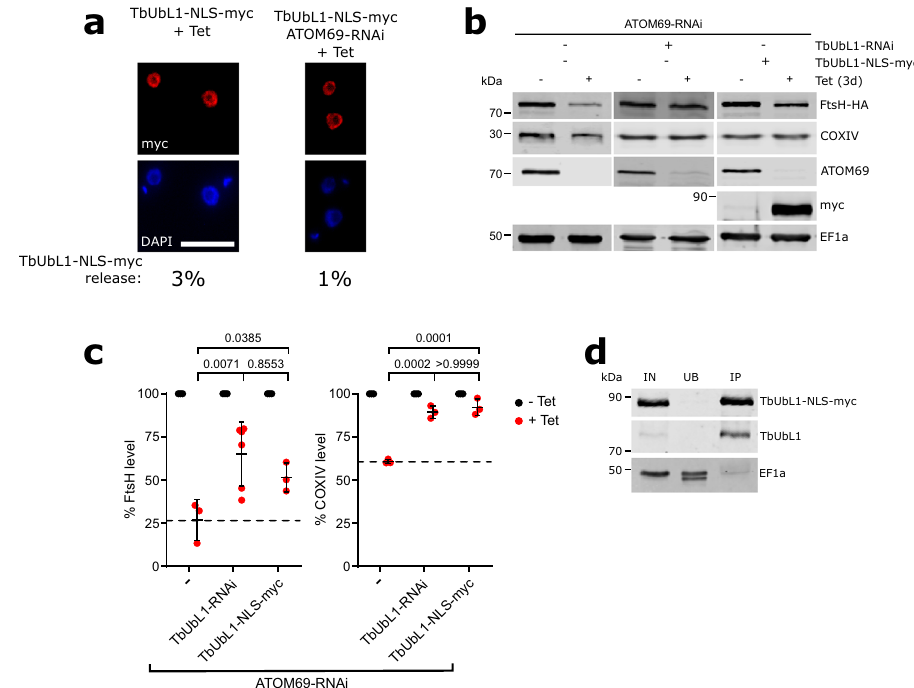
Fig. 7 Nuclear export of TbUbL1 is essential for proteasomal digestion of FtsH. a Left, immuno fl uorescence (IF) analysis of a cell line allowing tetracycline-inducible expression of ubiquitin-like protein 1 (TbUbL1) containing a nuclear localisation signal (NLS) in front of the C-terminal myc-tag (TbUbL1-NLS-myc + Tet). Right panels, IF analysis of a cell line allowing tetracycline-inducible expression of TbUbL1 containing a NLS in front of the C-terminal myc-tag together with simultaneous RNAi of atypical translocase of the outer membrane 69 (ATOM69) (TbUbL1-NLS-myc/ATOM69-RNAi + Tet). Cells were induced for 3d. Scale bar 10 μ m. The % of the population displaying a TbUb1-myc nuclear release phenotype is recorded below the images, 100 cells of each were analysed. This IF analysis was repeated independently at least three times with similar results. b Immunoblots depicting the change in abundance of in situ tagged FtsH-HA and endogenous cytochrome oxidase subunit IV (COXIV) in whole cells after tetracycline-inducible RNAi- mediated ablation of ATOM69 alone (left panels), in combination with RNAi-mediated ablation of TbUbL1 (middle panel), or in combination with tetracycline-inducible expression of TbUbL1-NLS-myc (right panel) are shown. Note that for the fi rst two cell lines, sections of blots already shown in Fig. 2a, b were used, with the anti-COXIV stained panels shown now in addition. 2 × 10 6 cells were loaded per lane. Elongation factor 1a (EF1a) is used as a loading control. c Quanti fi cation of triplicate immunoblots shown in b , with the tagged protein level of each uninduced cell line set to 100%. The level of tagged protein for each sample was normalised to its respective EF1a signal. Data are presented as mean values with error bars corresponding to the standard deviation of the mean of three independent biological replicates, except for the ATOM69/TbUbL1-RNAi cell line where six replicates were used to assess FtsH-HA level, as also used in Fig. 3b. Signi fi cance was calculated using a one way ANOVA followed by a Bonferroni posthoc test to allow for multiple comparisons, with the p -values calculated indicated in the graph. d Immunoprecipitation using myc-conjugated beads with whole cell extracts of the TbUbL1-NLS-myc expressing cell line induced for 1d. 5% whole cell equivalent (IN), 5% of the unbound protein fraction (UB) and 50% of the fi nal eluate (IP) were separated by SDS-PAGE. The resulting immunoblots were probed with anti-myc-tag antibodies (top panel), antisera against TbUbL1 (middle panel), and EF1a (bottom panel) which is used as a negative control. This IP analysis was repeated independently twice with similar results. Source data are provided as a Source Data fi TbUbL1-NLS-myc, was ectopically expressed under tetracycline control. The protein could be ef fi ciently expressed but the population of cells showing release of nuclear TbUbL1 was between 1 – 3% in uninduced and induced cells (Fig. 7a) which is even lower than 21% of cells that showed cytosolic staining of TbUbL1 in the uninduced ATOM69 RNAi cell line (Fig. 4a). For